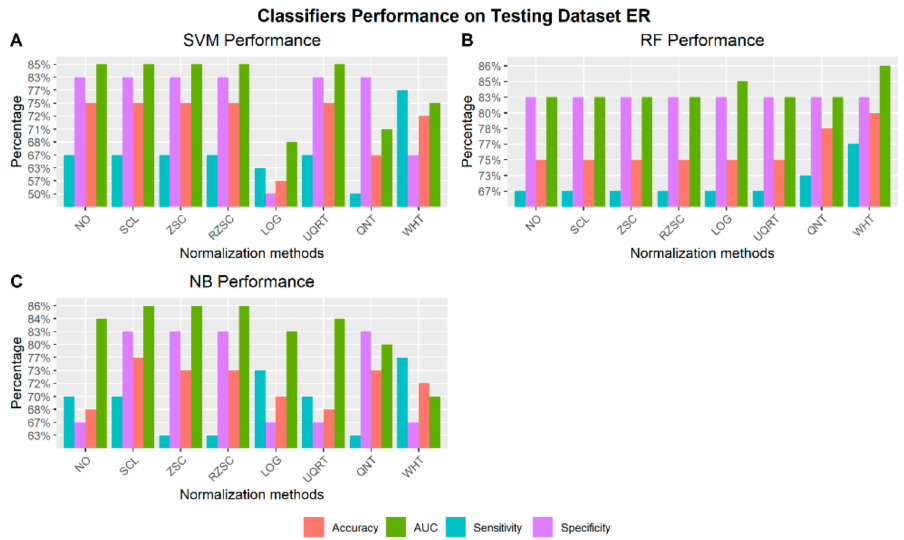
Figure 5. Classifiers performance on testing dataset to identify ER receptor status via radiomic features across normalization methods (NO: non-normalized features; SCL: Scaling normalization method; ZSC: Z-score normalization method; RZSC: Robust Z-score normalization method; LOG transformation; UPQRT: Upper Quartile normalization methods; QNT: Quantile normalization method; WHT: Whitening normalization method). A ) Support Vector Machine (SVM) Performance on Testing dataset ER + vs ER–. B ) Random Forest (RF) Performance on Testing dataset ER + vs ER–. C ) Naïve Bayesian (NB) Performance on Testing dataset ER + vs ER–.